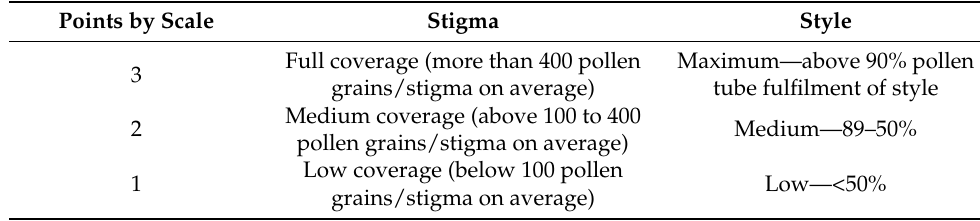
Table 1. Pollen tube overgrowth assessment scale